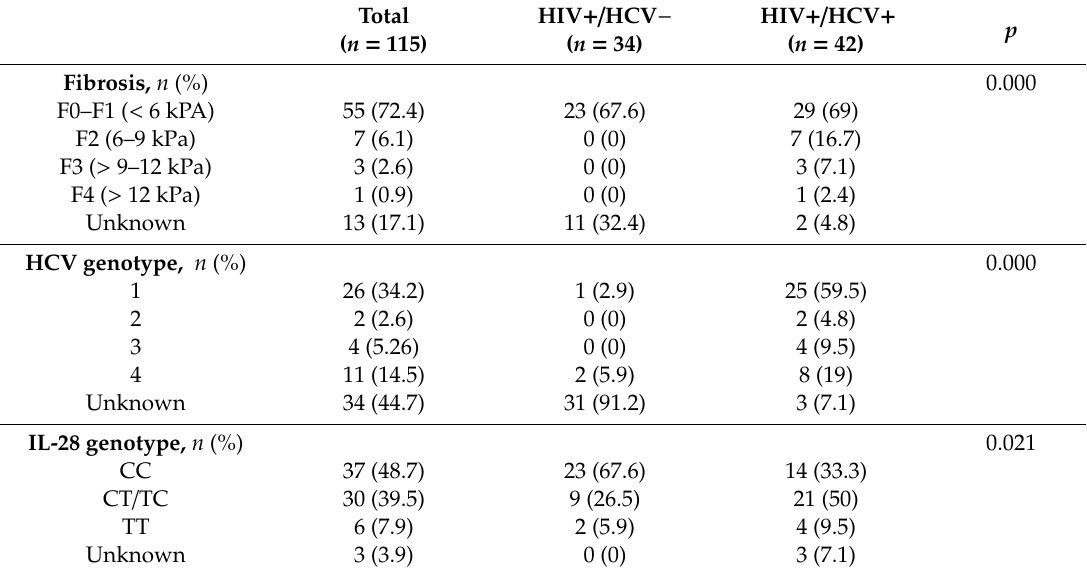
Table 3. Clinical characteristics, virological data and genetic data of study patients related to HCV infection.